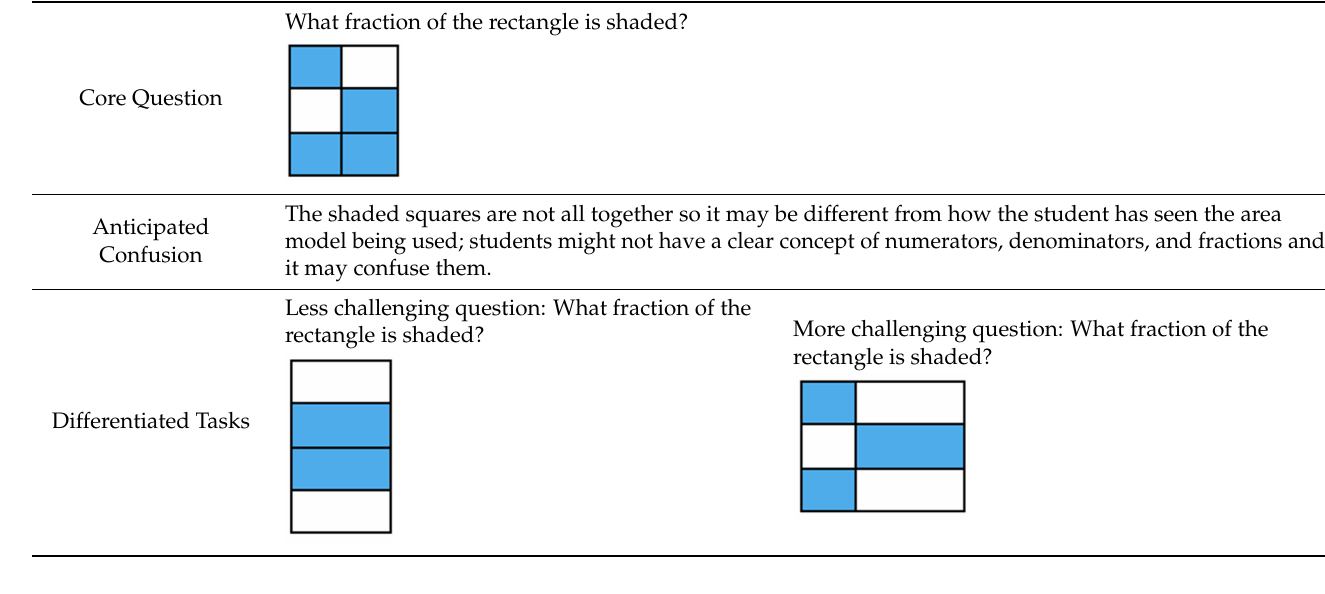
Table A1. An Example of a PST’s